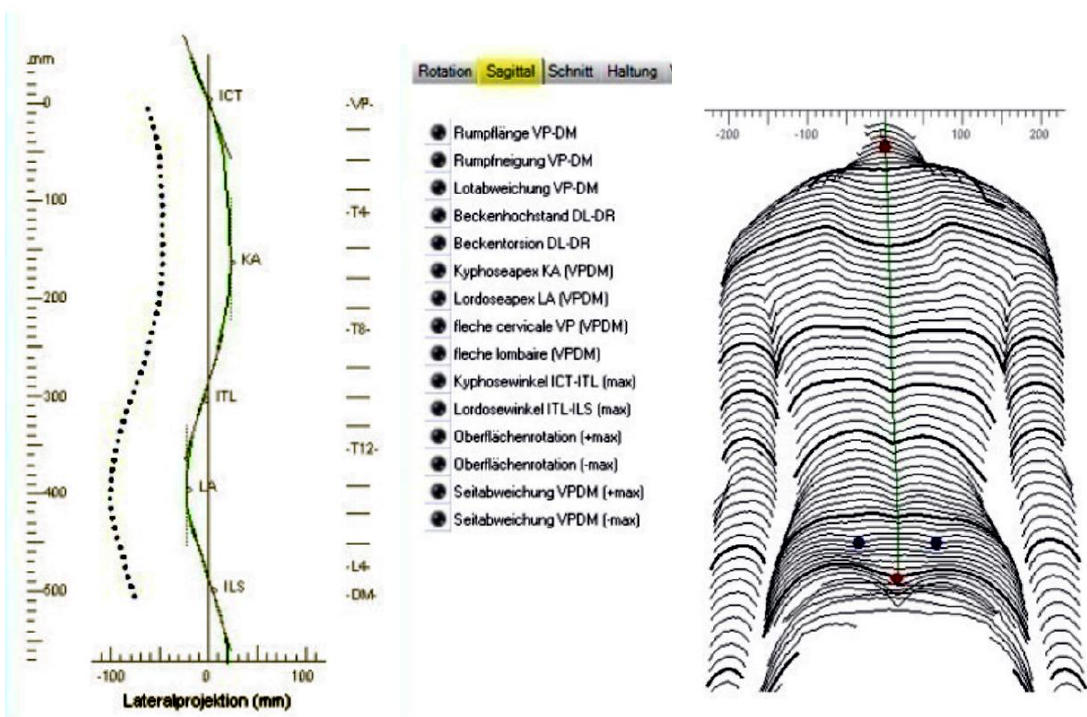
Figure 2. VP = Vertebra prominence, this corresponds to ICT (zero 0 mm), KA = Kyphotic Apex, LA = Lordotic Apex. If the (VP-KA) distance is shorter, that is, if the IS thoracic vertebra corresponding to KA is higher at the thoracic spine, then the value of the distances’ ratio (VP-KA)/(VP-LA) turns smaller, because the nominator of the quotient is smaller, (shorter VP-KA) distance. If this ratio were statistically significantly correlated with the Cobb angle and the truncal asymmetry, this would imply that this morphology (higher KA in IS) would be a primary aetiological factor for the commencement of IS. But this is not the case!